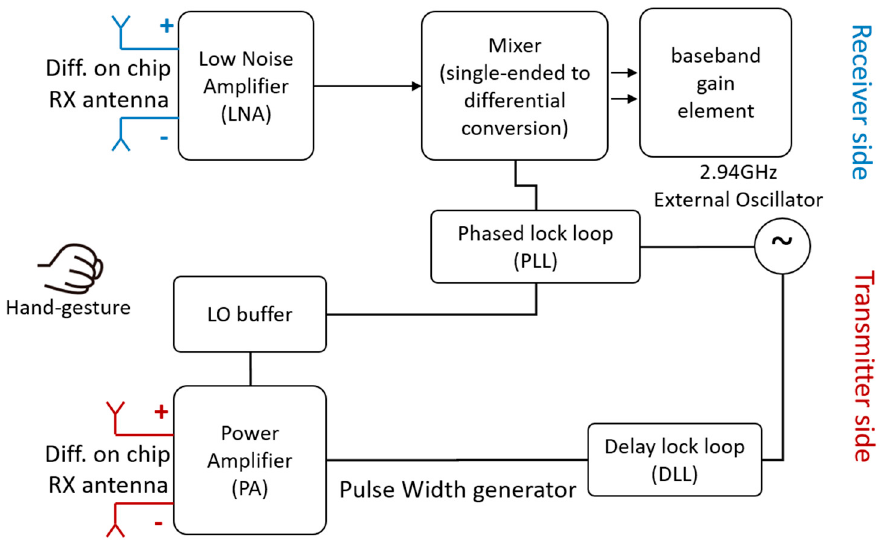
Figure 4. Block diagram of 94 GHz pulsed radar designed for hand-gesture sensing [38].